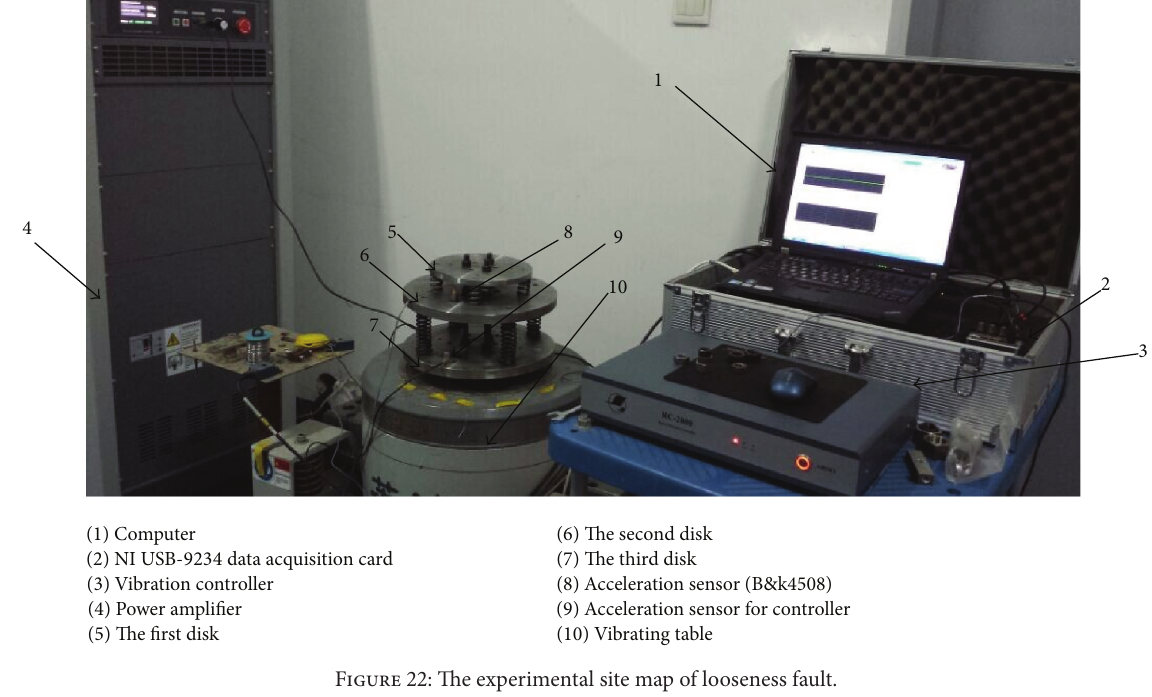
Figure 22: The experimental site map of looseness fault.